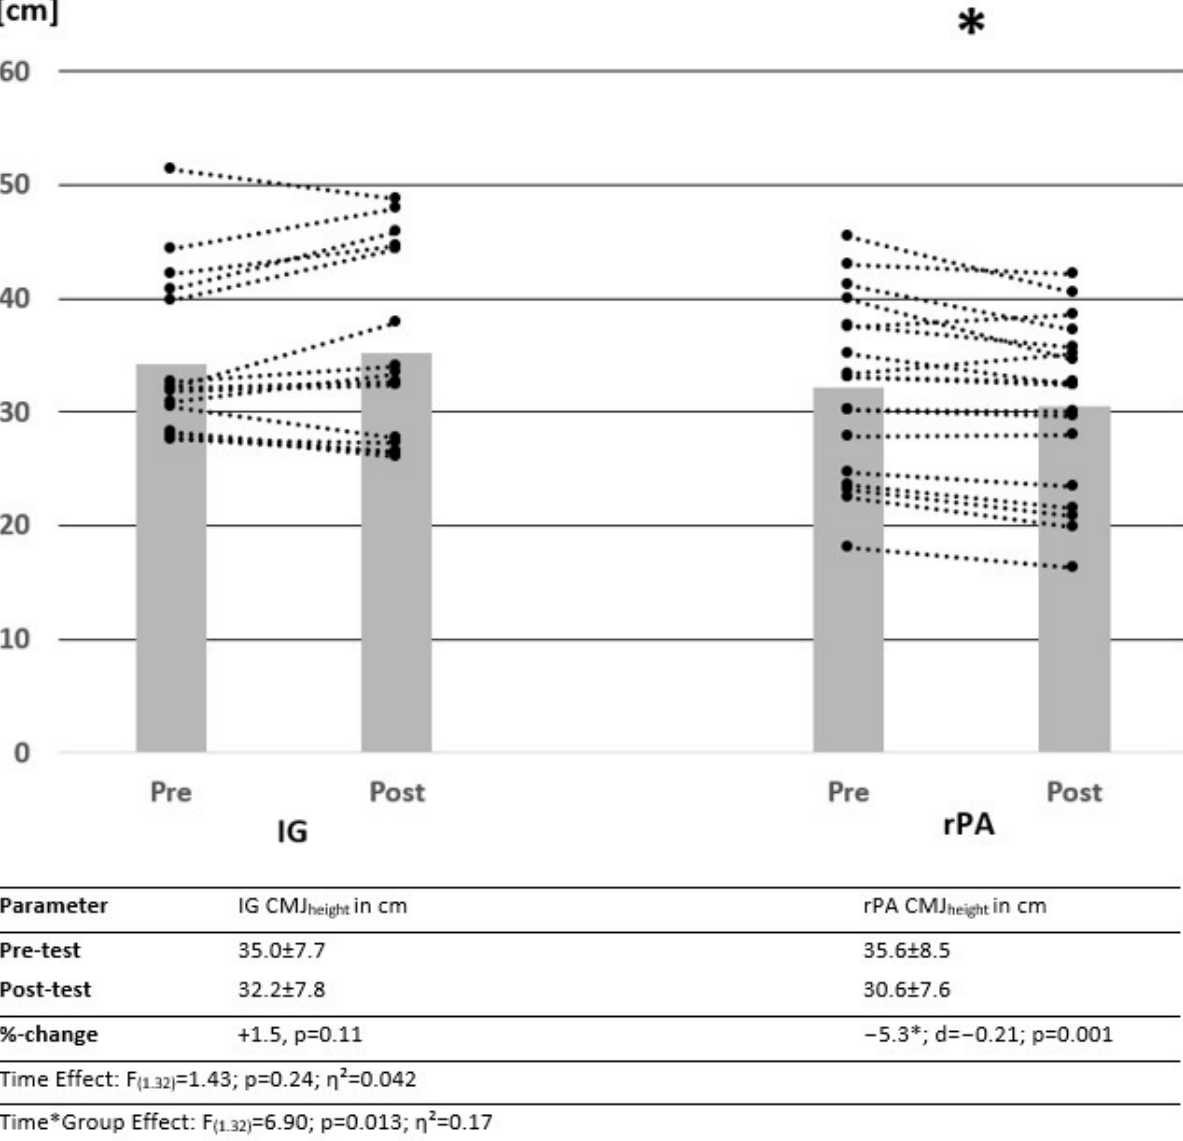
Figure 5. Change in mean values and individual cases of countermovement jump of control and intervention groups over time. Data presented as means ± SD. IG = intervention group, rPA = reduced physical activity group, CMJ = countermovement jump, * = significantly different from pre- to post-test.